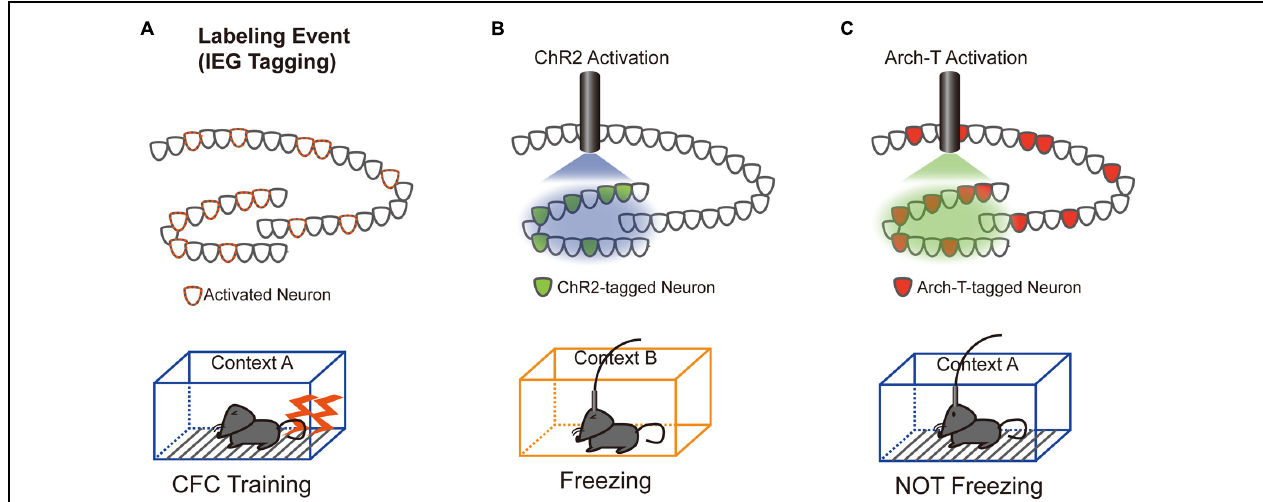
FIGURE 1 | Schematics of the optogenetic intervention experiments. (A) DG neurons activated during contextual fear conditioning (CFC) training in a conditioned context (context A) were labeled with either Channelrhodopsin 2 (ChR2; B ) or Archaerhodopsin (Arch-T; C ), whose expression is controlled by IEG promoters. (B) Trained mice show freezing responses during unconditioned context (context B) exposure only when the c- fos -positive ensemble expressing ChR2 was reactivated by blue light illumination (Liu et al., 2012). (C) Consistent with the ChR2 reactivation data, trained mice show no freezing responses to conditioned context A only when neuronal activity of the Arc -positive ensemble expressing Arch-T was inhibited by green light illumination (Denny et al., 2014).